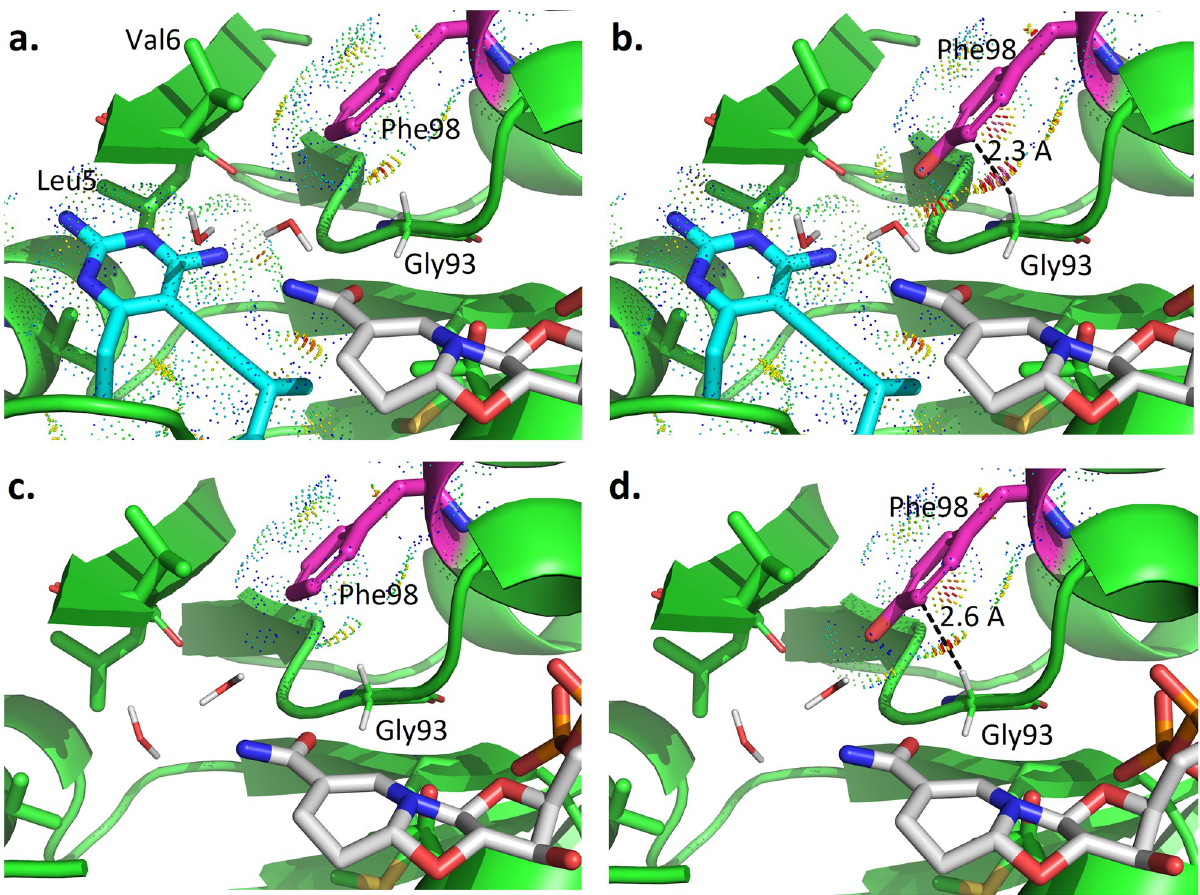
Fig 6. OSPREY -predicted low energy conformations for t-NADPH related complexes. a. Ternary complex of R27:t-NADPH:DHFR(WT) b. Ternary complex of R27:t-NADPH:DHFR(F98Y) c. Binary complex of t-NADPH:DHFR(WT) d. Binary complex of t-NADPH:DHFR(F98Y).